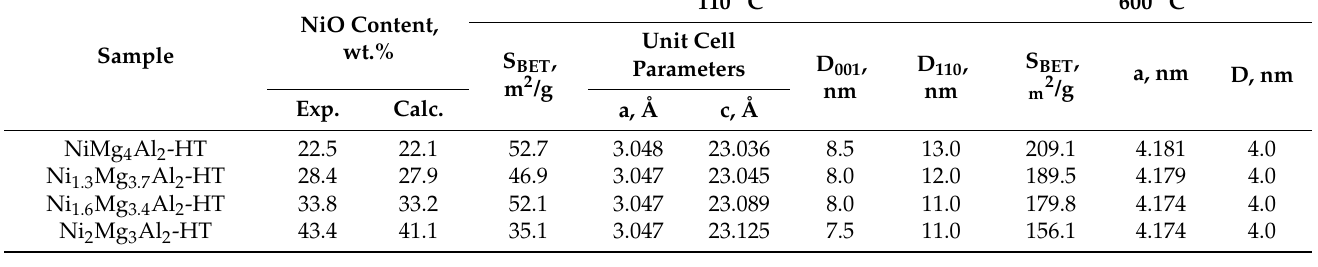
Table 1. Composition and X-ray diffraction data for the dried and calcined samples.